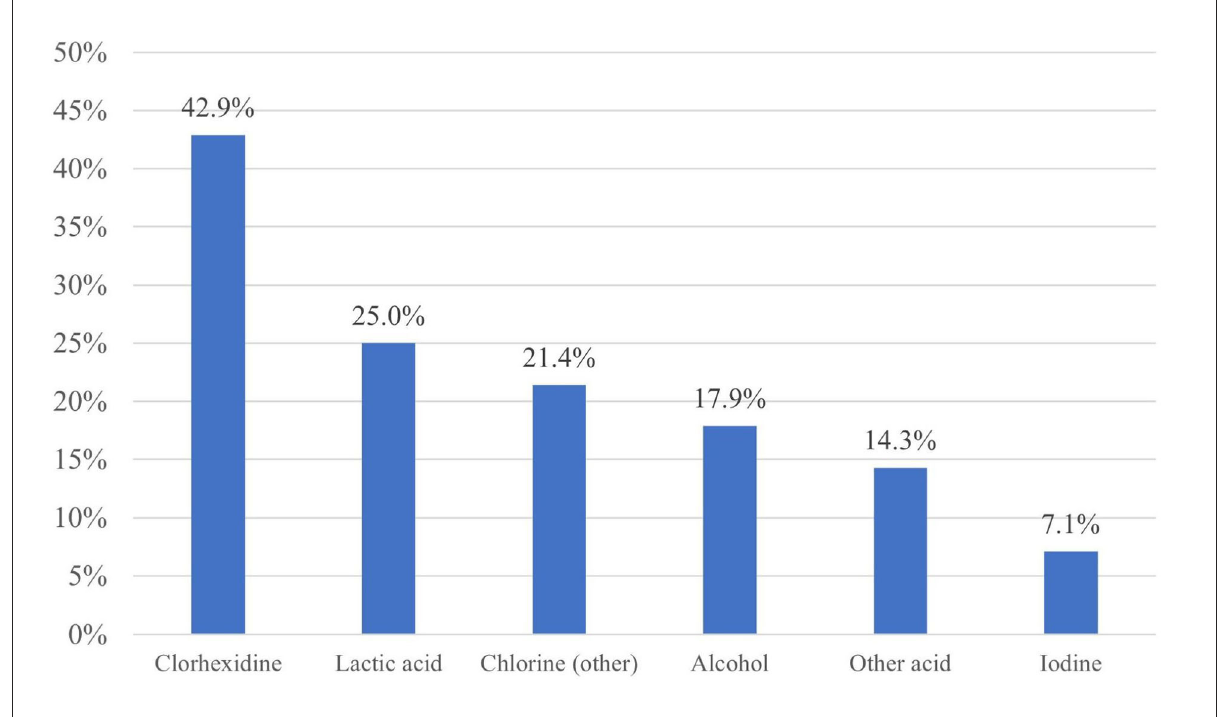
FIGURE1 Active ingredients of the pre-milking teat disinfectants ( n = 28).